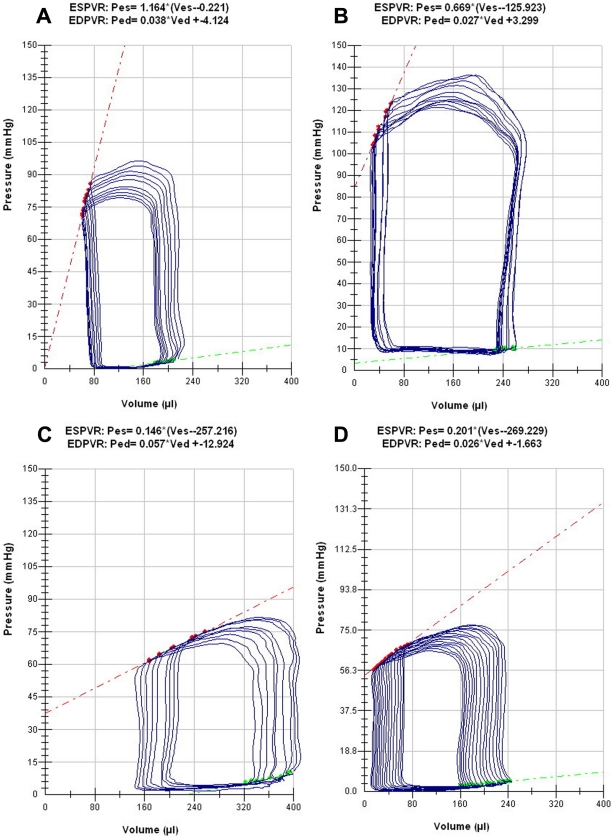
Representative pressure volume (PV) loops during preload reduction.Note the steeper slope of EDPVR (green line) and rightward shift in the diabetic group (C) compared to control (A). An increase in the slope of EDPVR indicated decreased chamber compliance as seen in the diabetic animals which was reduced with DiOHF treatment (D). *P<0.05 vs control (non-diabetic) rats; †P<0.05 vs diabetic rats.